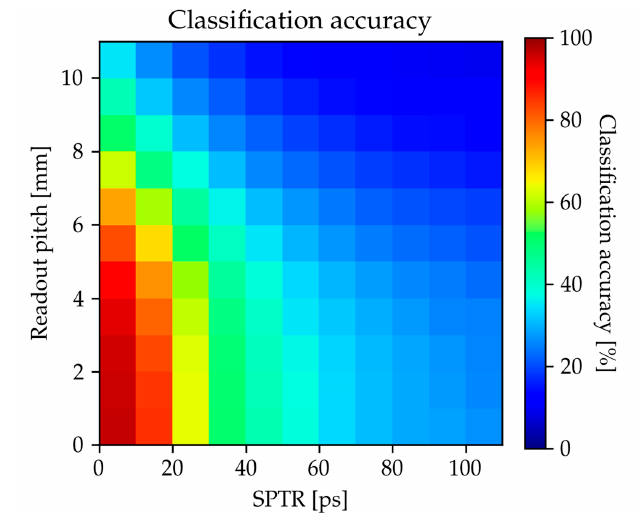
Figure 4. Classification accuracy relative to SPTR and readout pitch. Table 2. Classification accuracy at representative conditions.